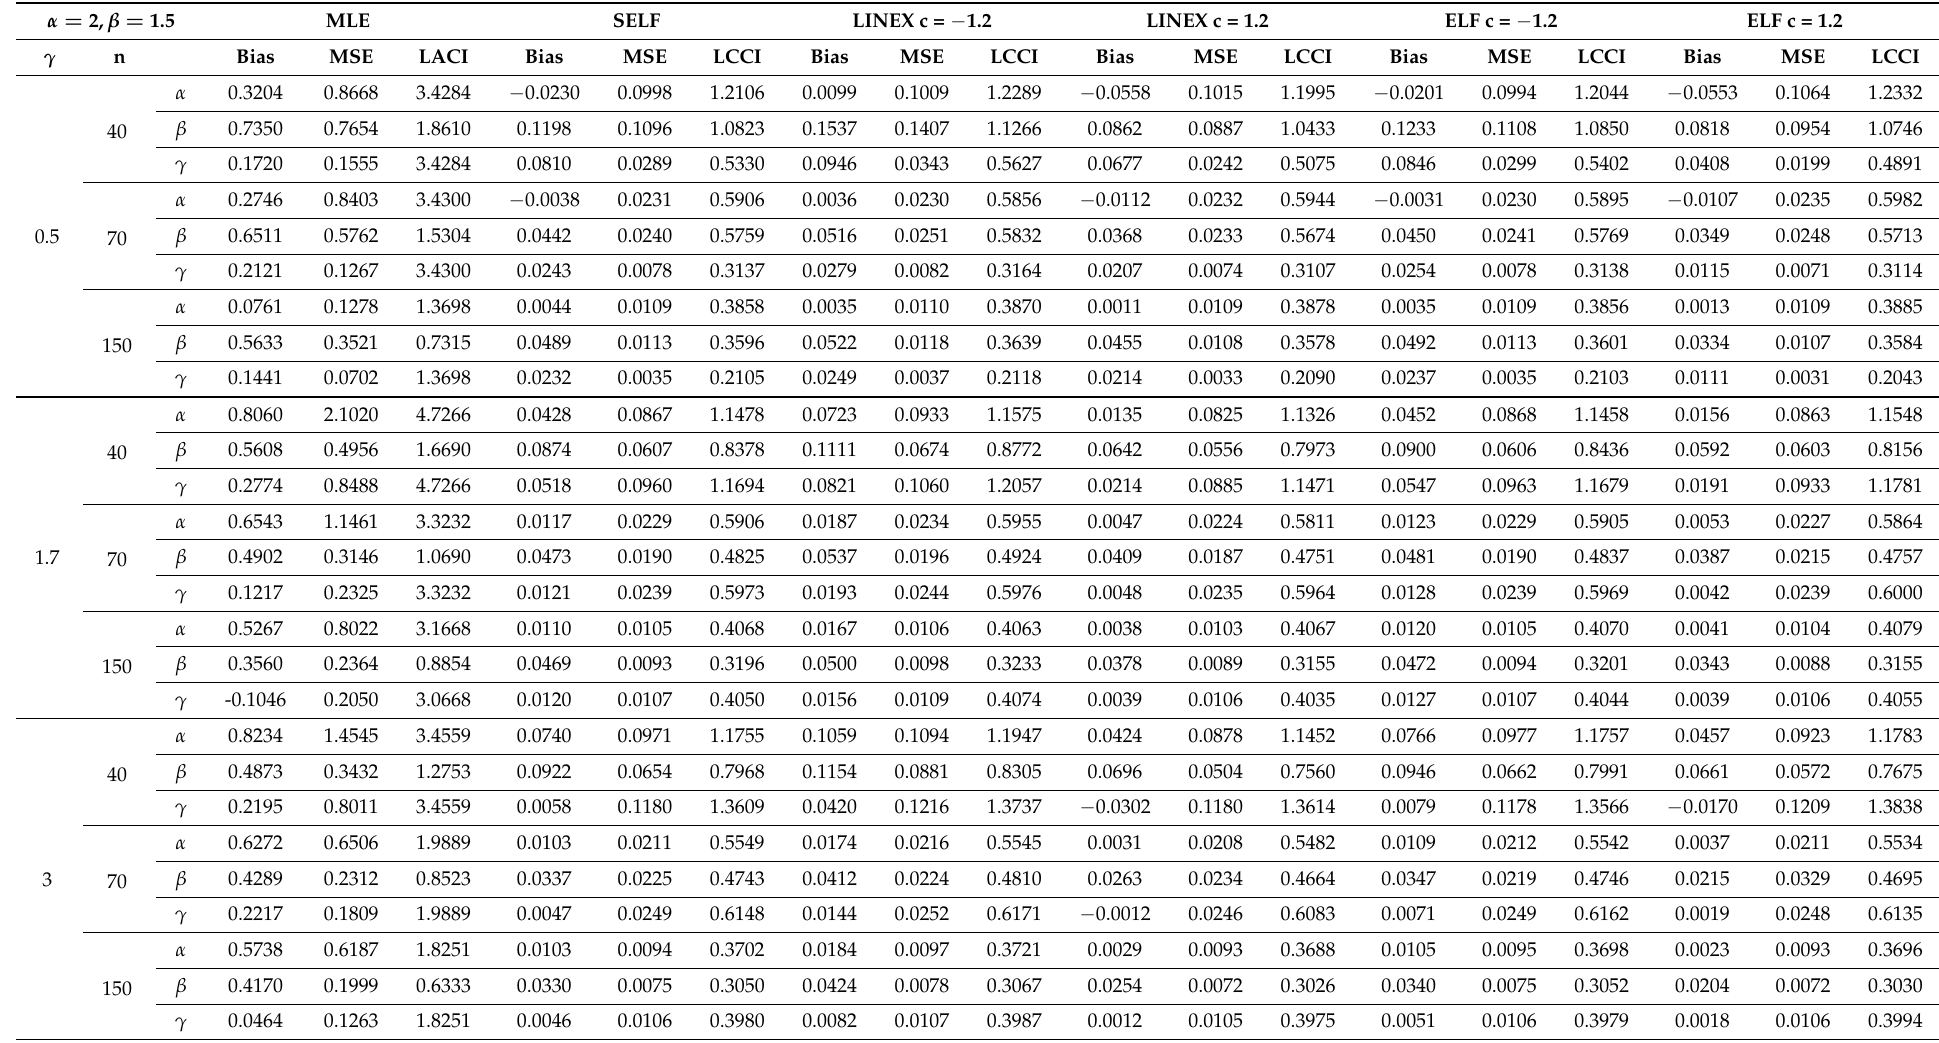
Table 5. Bias, MSE and LCI for MLE and Bayesian estimation methods for α = 2, β =